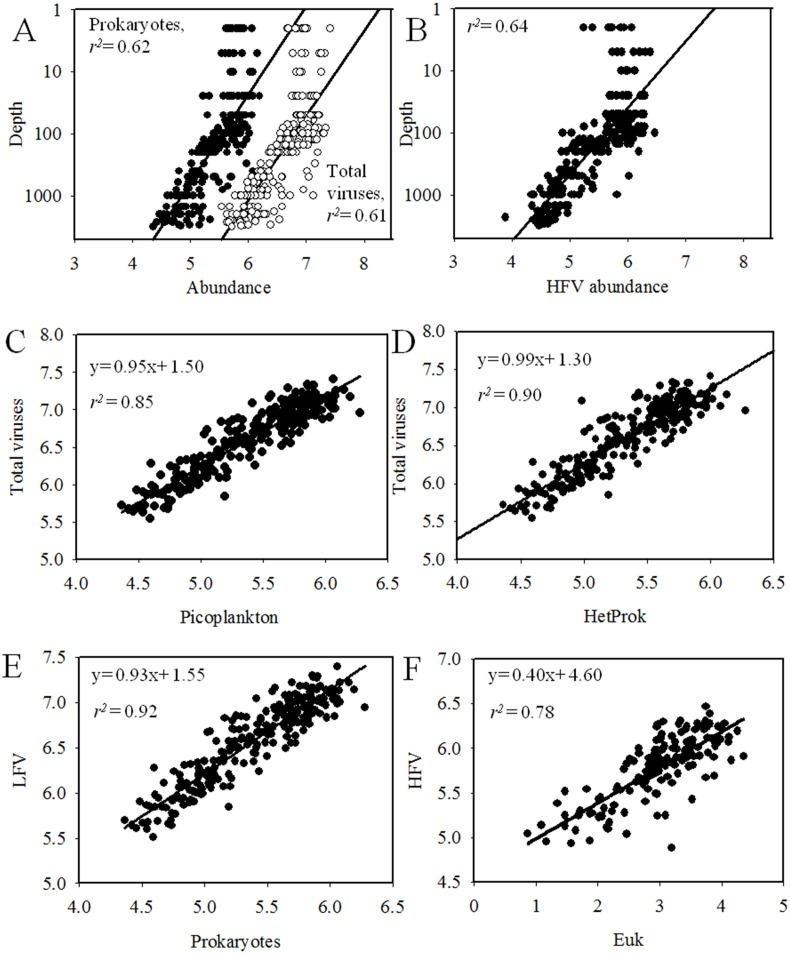
Relation between the abundance of prokaryotes and total viruses versus depth (A), LFV versus depth (B), total viruses versus picoplankton (C), total viruses versus HetProk (D), LFV and prokaryotes (E) and HFV abundance and Euk (F) in the whole water column of 22 vertical-sampling stations.The fitting function used is: y = ax+b, all the data were log transformed. Abbreviations: LFV, low fluorescence viruses; HFV, high fluorescence viruses; HetProk, heterotrophic prokaryotes; Euk, picoeukaryotes.